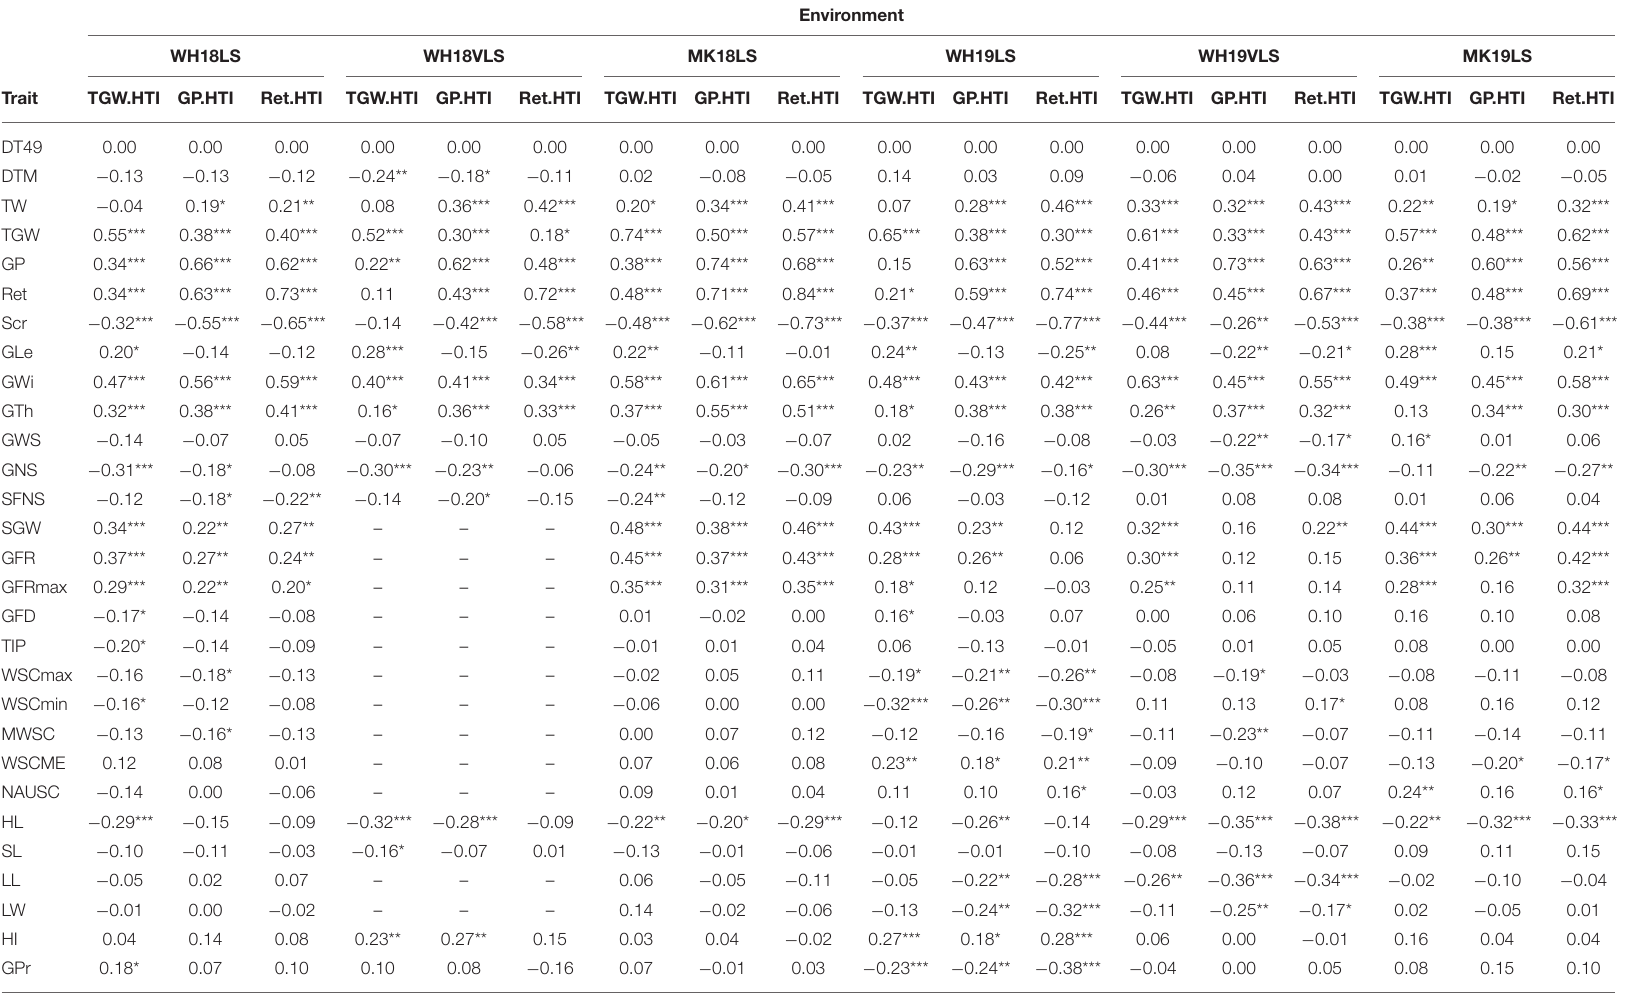
TABLE 4 | Correlations between thousand-grain weight, grain plumpness, and retention heat tolerance indices (TGW.HTI, GP.HTI, and Ret. HTI, respectively), and traits measured within each delayed sown